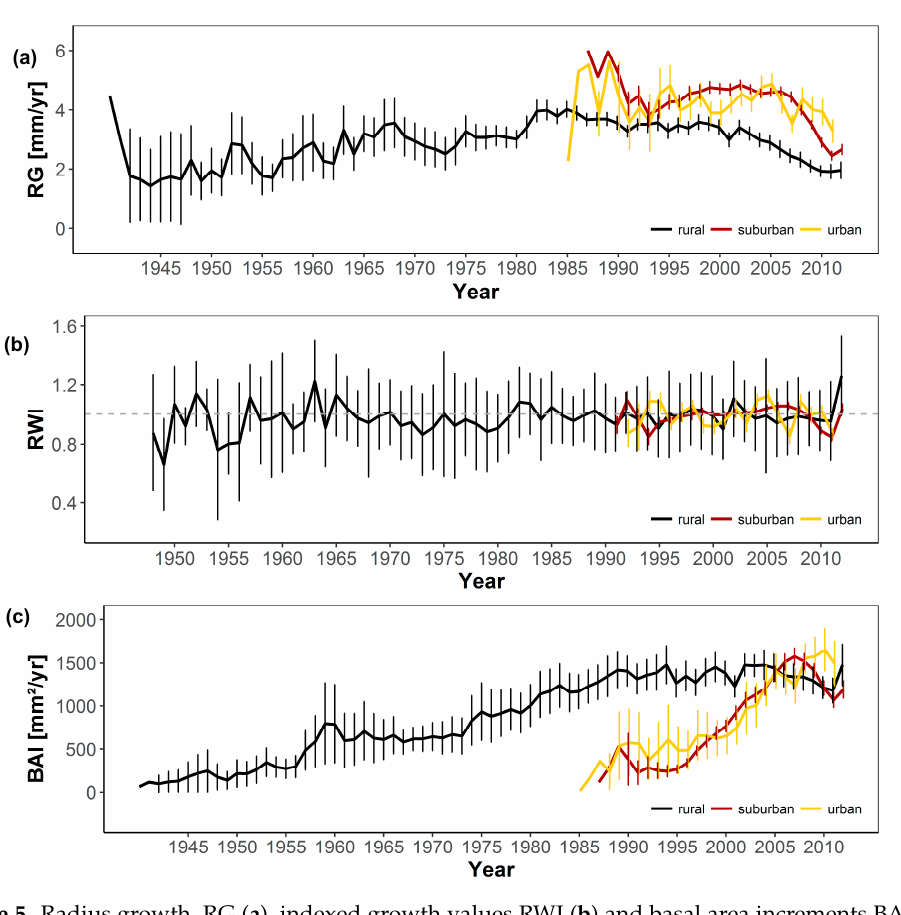
Table 5. Mean radius growth rate [mm/yr], mean sensitivity and autocorrelation (autoregressive, AR) of urban, suburban and rural chronologies, as well as for the overall mean chronology of A. sachalinensis in Sapporo, Japan for their total period of growth .